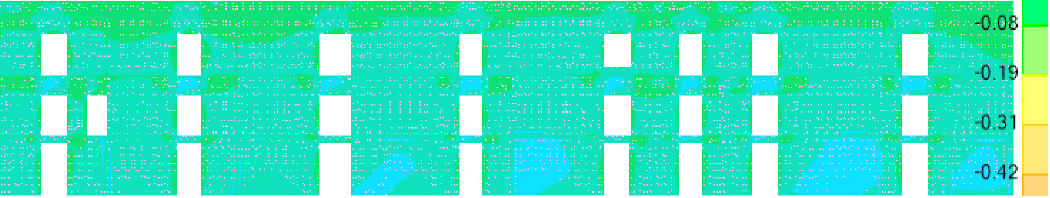
Figure 15. Compressive force per meter at section cut ‐ 3 (Figure 10) under load combination dead + live + response spectrum ‐ x.